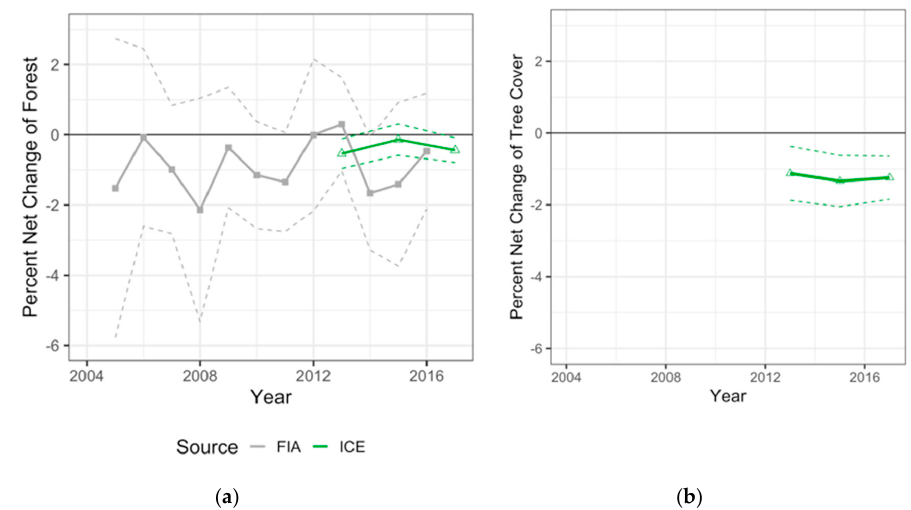
Figure 7. Estimates of percent net change ( a ) in forest land use and ( b ) in tree cover with 95% confidence intervals from FIA data (gray closed squares) at five-year intervals and ICE (green open triangles) at 2–3 year intervals.